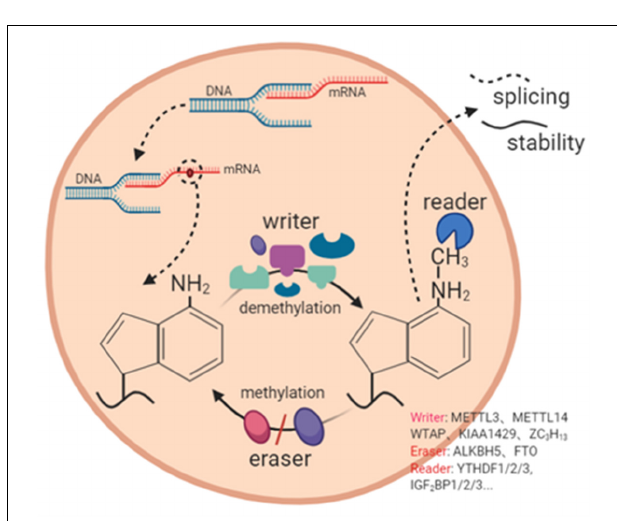
FIGURE 2 | The mechanism of m6A RNA modification. m6A RNA modification is a dynamic and complex process with the participation of m6A methylase (writer), m6A demethylase (eraser), and m6A binding protein (reader). It participates in RNA splicing, RNA stability and other